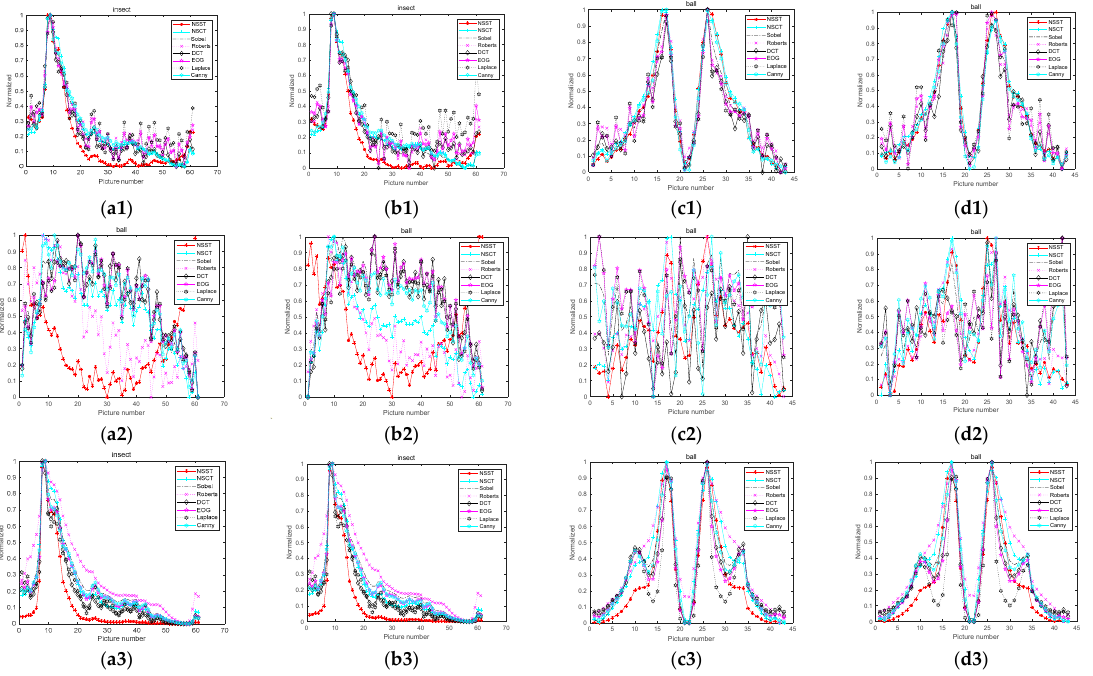
Figure 9. Curves after noises and filters are added: ( a1 ) Gaussian noise and bilateral filter of insects; ( b1 ) Gaussian noise and guided filter of insects; ( c1 ) Gaussian noise and bilateral filter of ball; ( d1 ) Gaussian noise and guided filter of ball; ( a2 ) salt-and-pepper noise and bilateral filter of insects; ( b2 ) salt-and-pepper noise and guided filter of insects; ( c2 ) salt-and-pepper noise and bilateral filter of ball; ( d2 ) salt-and-pepper noise and guided filter of ball; ( a3 ) Poisson noise and bilateral filter of insects; ( b3 ) Poisson noise and guided filter of insects; ( c3 ) Poisson noise and bilateral filter of ball; ( d3 ) Poisson noise and guided filter of ball.